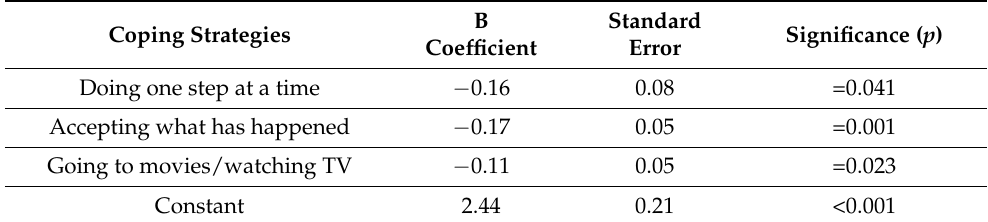
Table 11. The backward selection type of multivariate logistic regression model with coping strategies for burnout (Nagelkerke R Square = 0.34).